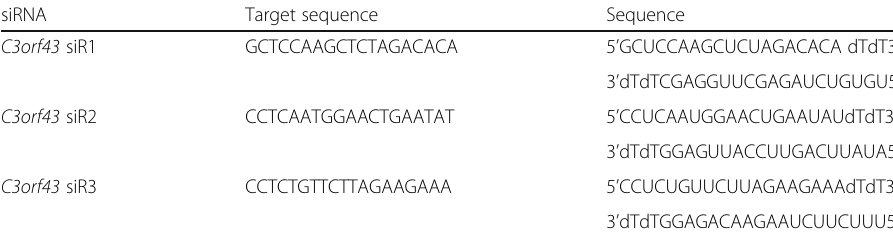
Table 1 The sequence of C3orf43 siRNAs